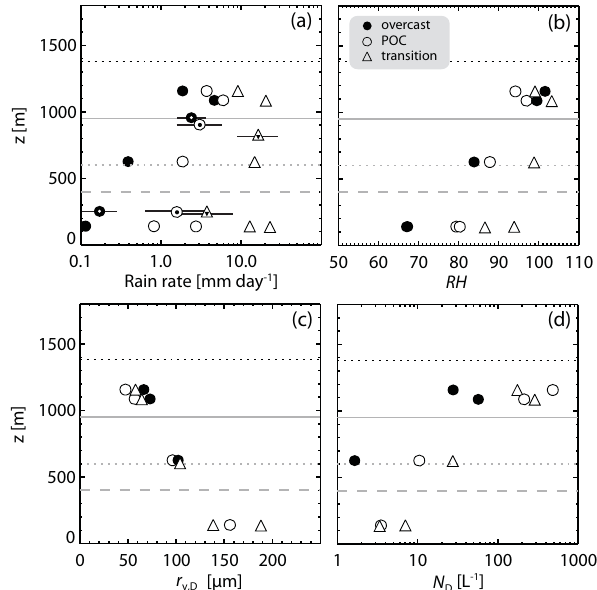
Fig. 9. Profiles from RF06 of mean values of (a) precipitation rate (radar estimated values are shown for the height of maximum re- flectivity and at 250m by symbols with dots and horizontal bars show leg-leg variability), (b) relative humidity, (c) volume radius of drizzle drops, and (d) drizzle drop concentration in samples where the drizzle concentration exceeds 1L − 1 . Symbolia are the same as for Fig.